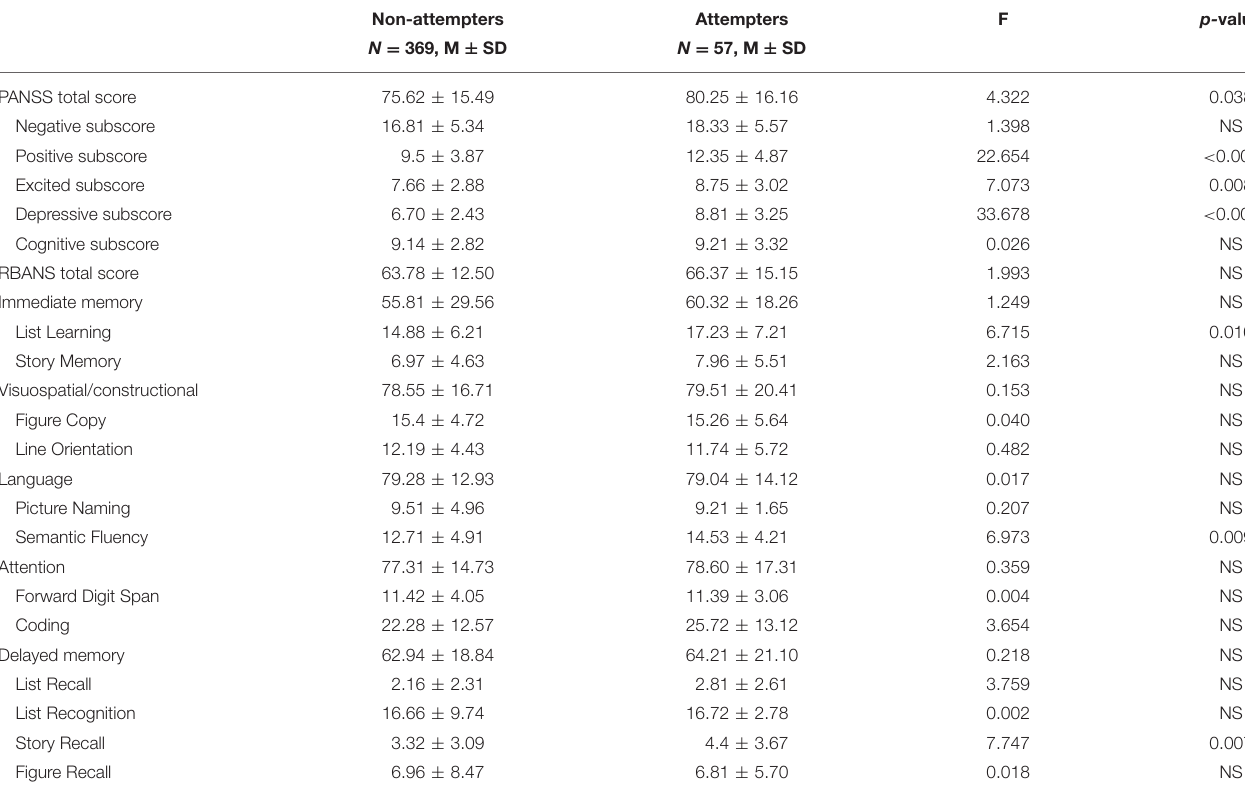
TABLE 2 | Clinical variables and cognitive functions between attempters and